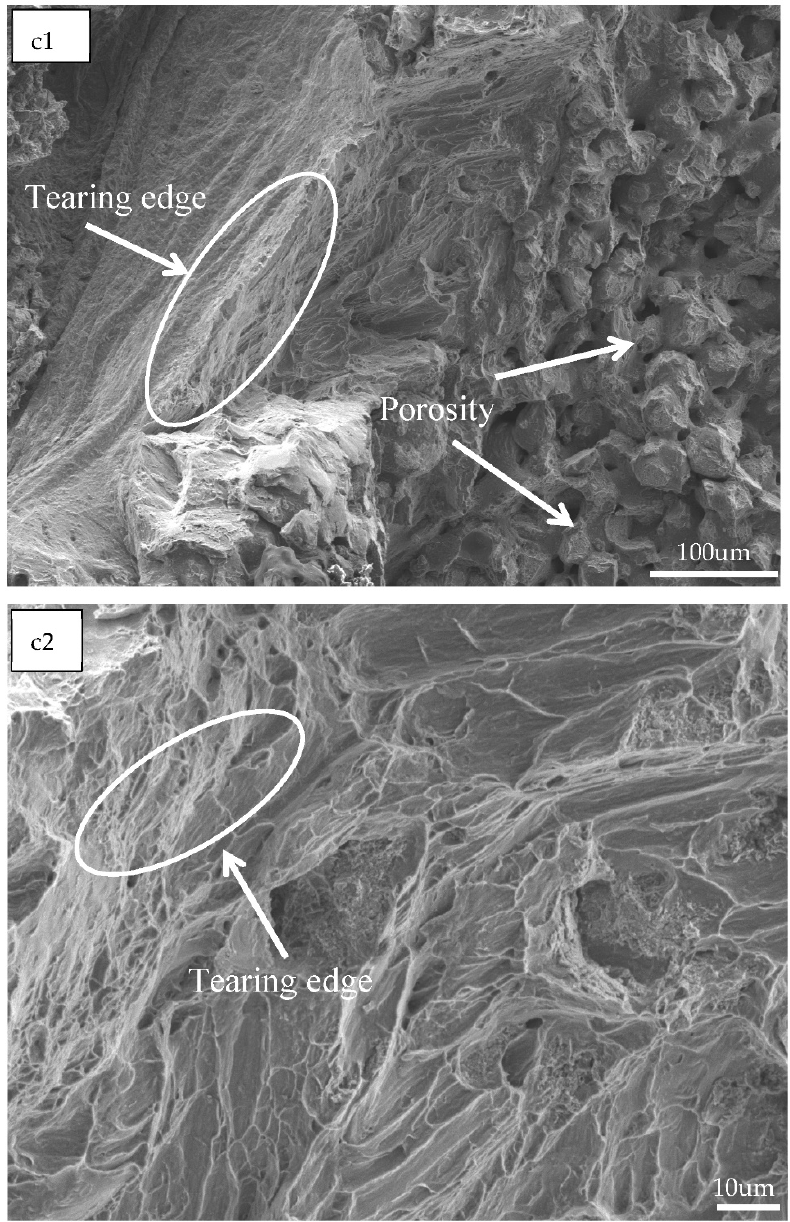
Figure 10. Fracture morphology of alloy ( a1 , a2 ) Mg-0.5%Mn-2%Zn, ( b1 , b2 ) Mg-1.0%Mn-2%Zn, and ( c1 , c2 ), Mg-1.5%Mn-2%Zn.